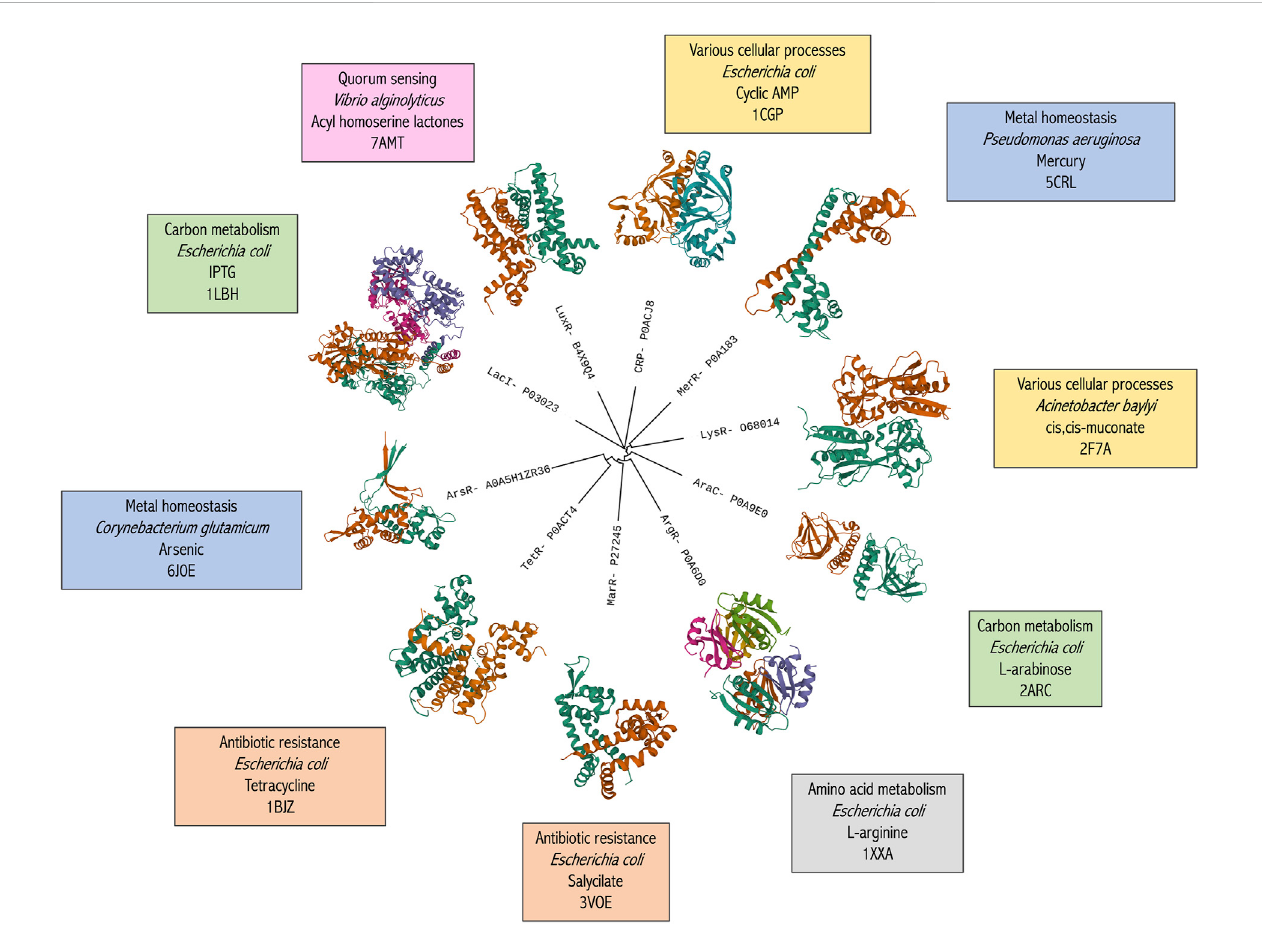
FIGURE 1 Broad phylogenetic classi fi cation of the ten most common bacterial aTF families. Family name and representative UniProt IDs are used as tree labels. Structure images were obtained using Mol* Viewer (Sehnal et al., 2021) via RCSB PDB. The text boxes detail, in order, the most common aTF-controlled pathway, the species name of the speci fi c aTF, the representative effector molecule and the PDB identi fi er of the